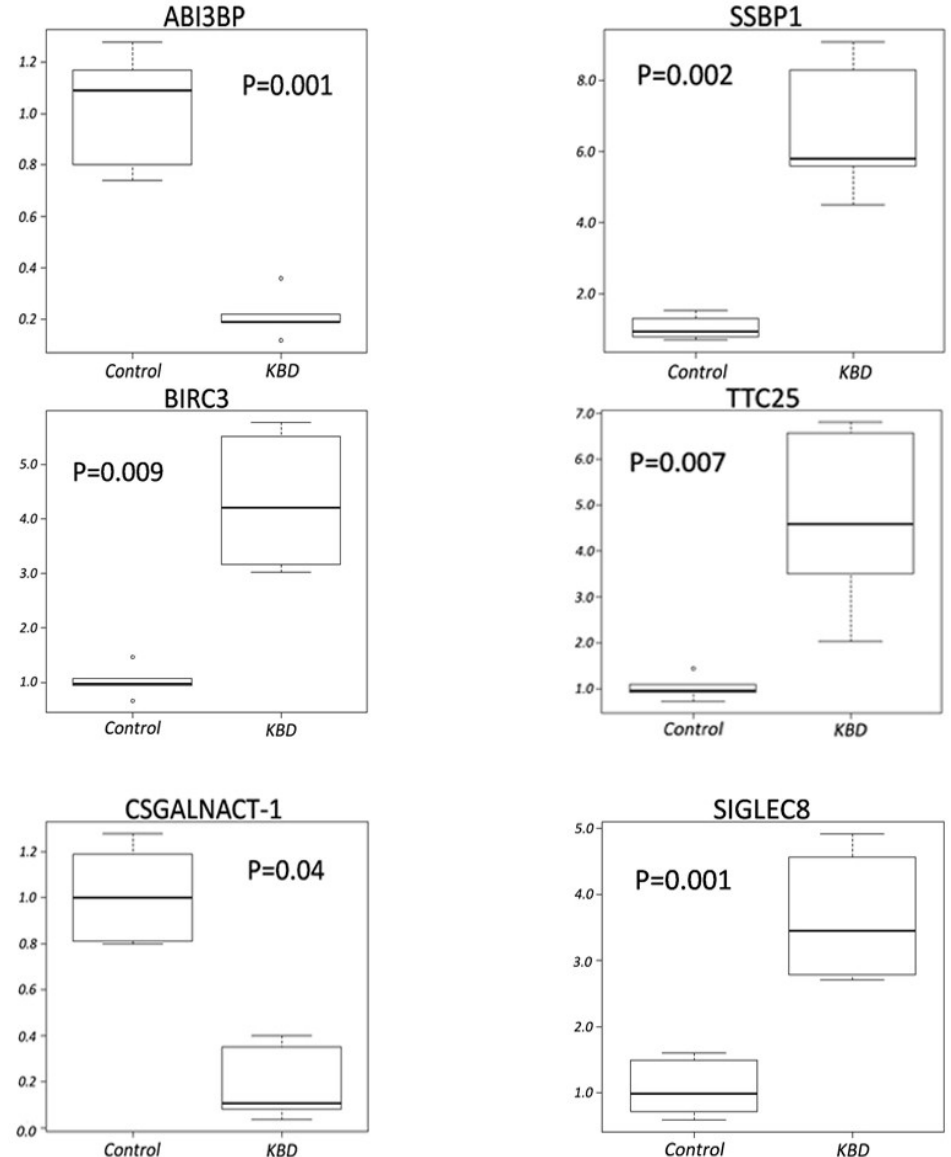
Figure 1. mRNA levels for ABI3BP, SSBP1, BIRC3, TTC25, CSGALNACT-1 and SIGLEC8 in PBMCs of controls and KBD patients.Steady-state mRNA levels were quantitated by two-step SYBR Green real time RT-PCR. The comparative Ct method was used for the calculation. The lines inside the boxes denote the medians. The boxes mark the interval between the 25th and 75th percentiles. The whiskers denote the interval between the 10th and 90th percentiles. The “○”indicates data outside the 10th and 90th